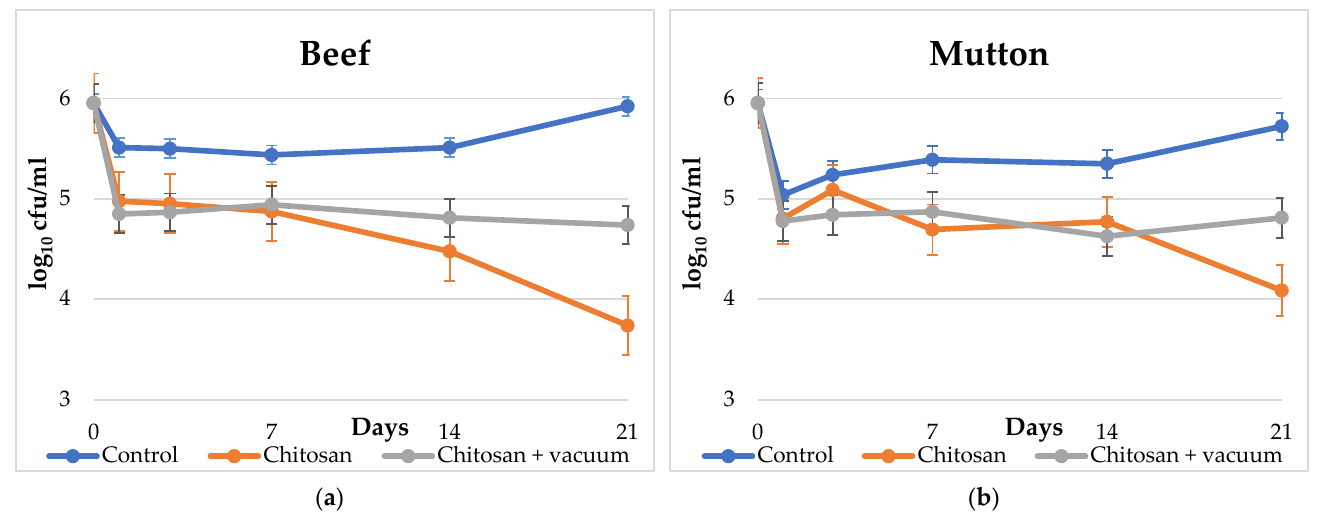
Figure 2. L. monocytogenes populations during the storage of beef ( a ) or mutton ( b ) under refrigeration for 21 days.